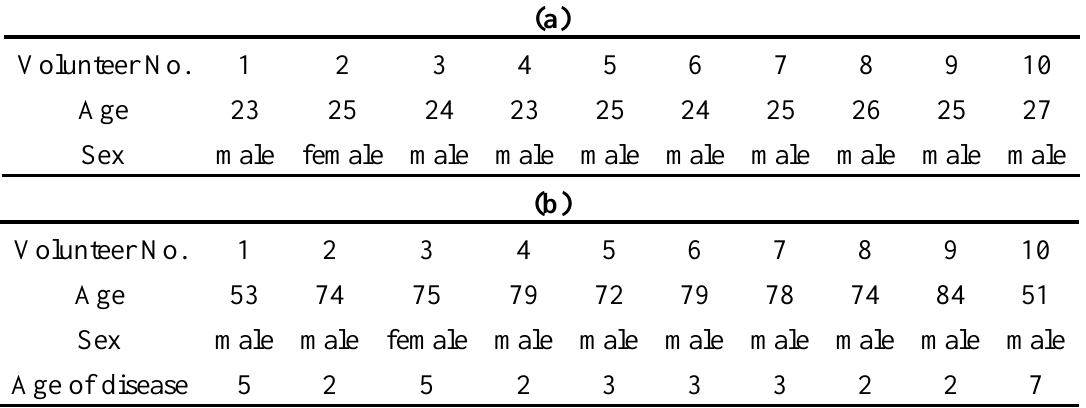
Table 2. Test subjects were divided into two main groups: (a) normal human (b) identified as patients of Parkinson’s disease.